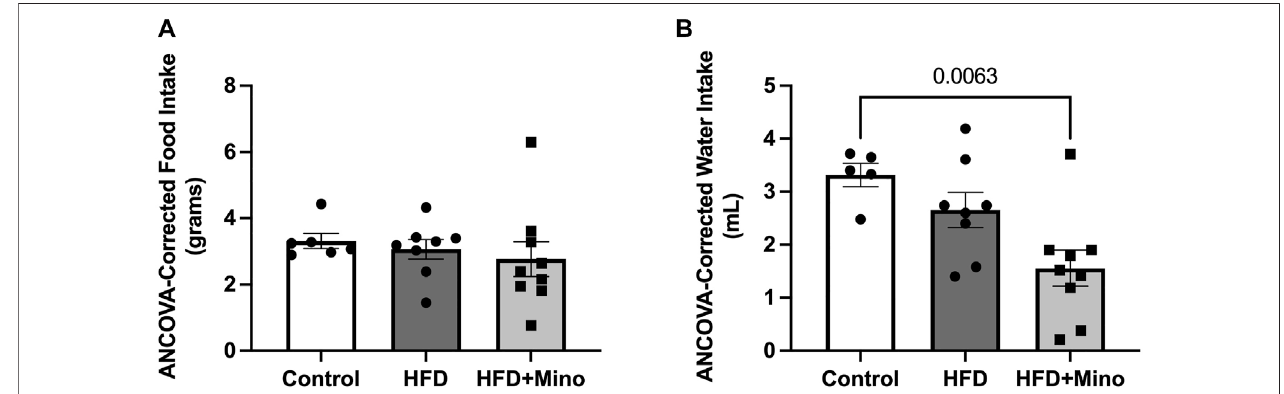
FIGURE2| MinocyclinedoesnotalterHFD-inducedchangesinfoodandwaterintake.Foodandwaterconsumptionwereassessedovera24-hperiodinasubset of control diet (Control; n = 6), high fat diet (HFD; n = 7), and HFD mice treated with minocycline (HFD+Mino; n = 15) during the last week of study. Thesemeasurements were corrected for body mass via analysis of covariance (ANCOVA). (A) Grams of food consumed did not differ among groups. (B) HFD and HFD+Mino groups consumed less milliliters of water compared to Control.